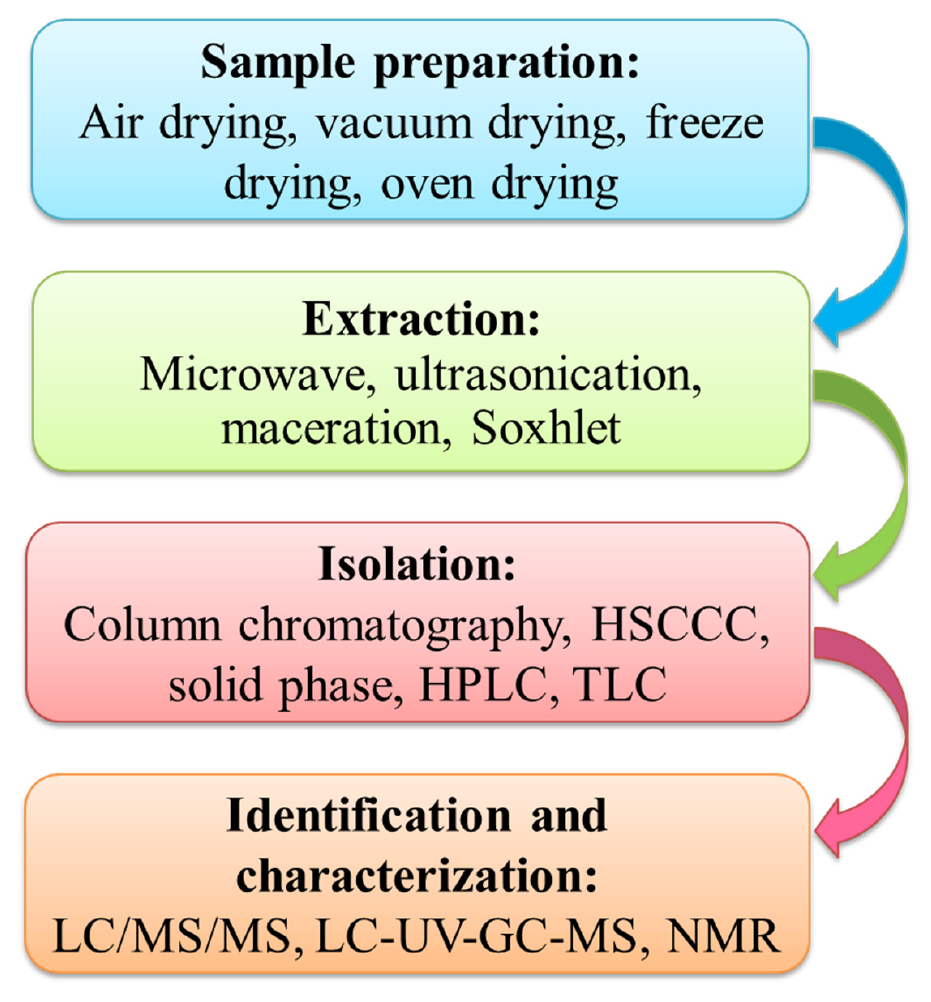
Figure 1. General scheme of sample preparation, extraction, isolation, identification, and characteri- zation of phenolic compounds.